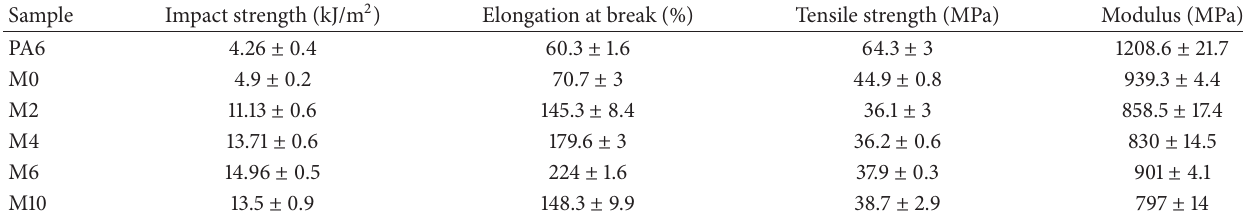
Table 3: Mechanical properties of samples.